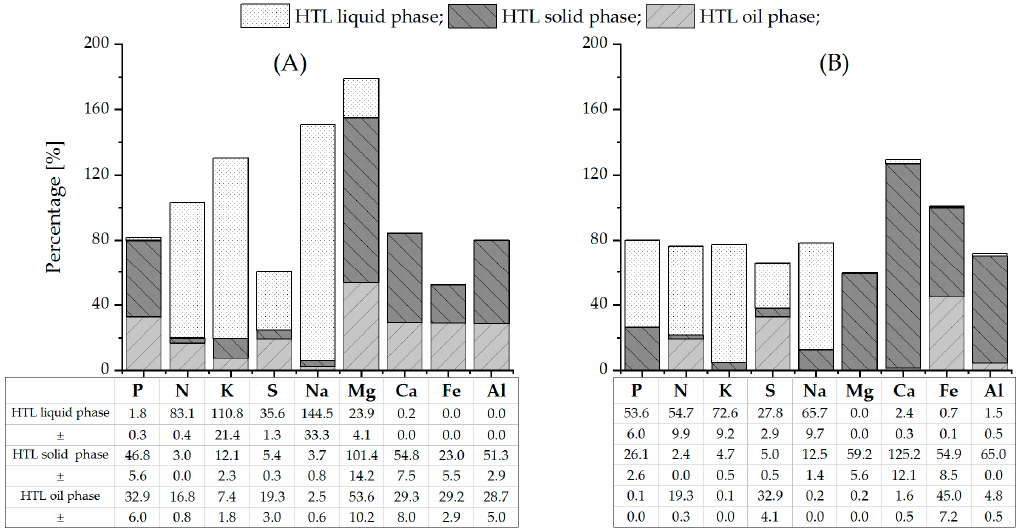
Figure 2. Estimated elemental balance for HTL runs of PSS ( A ) and SPR ( B ) (MV ± SD; error bars are not shown in the